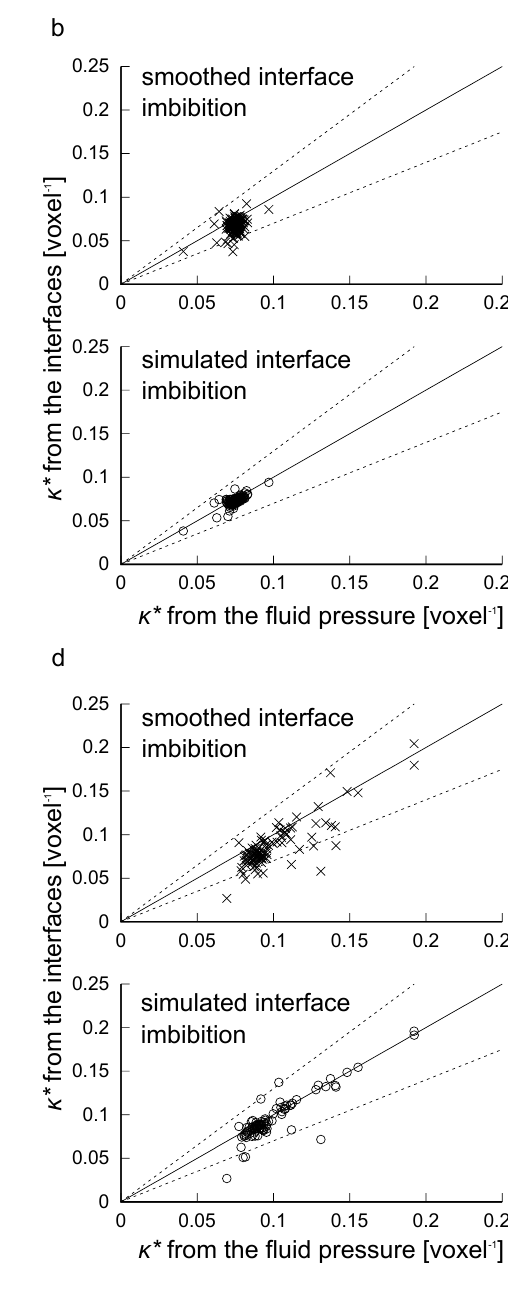
Figure 16. Comparison between the dimensionless mean curvature ( κ ∗ ) obtained from the simulated fluid pressure and that obtained from the fluid interfaces. ( a ) Bead pack after drainage; ( b ) Bead pack after imbibition; ( c ) Bentheimer sandstone after drainage; ( d ) Bentheimer sandstone after imbibition. Here, a unit slope indicating perfect agreement in these values is shown by a black solid line, while ± 30% difference is shown by the black dotted